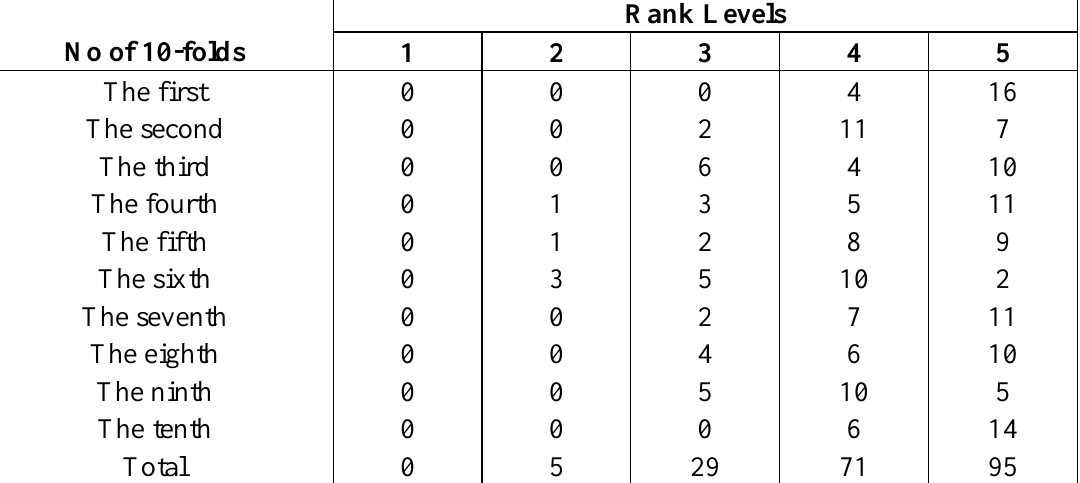
Table 7. Number of rank orders in 10-fold cross validation with 20